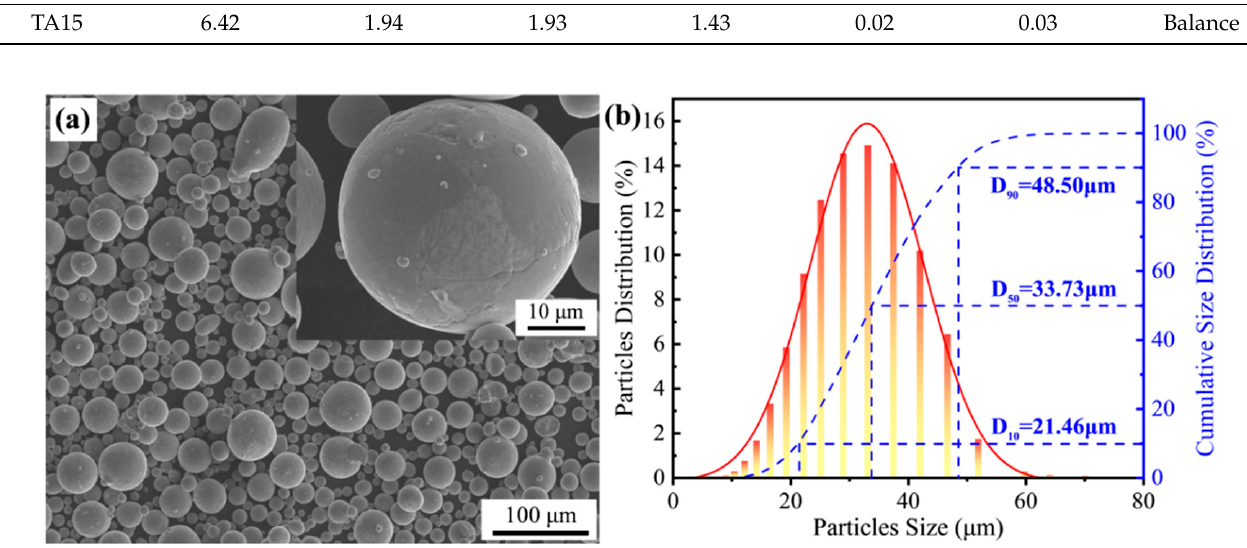
Figure 1. Morphology ( a ) and size distribution ( b ) of TA15 titanium alloy powder.